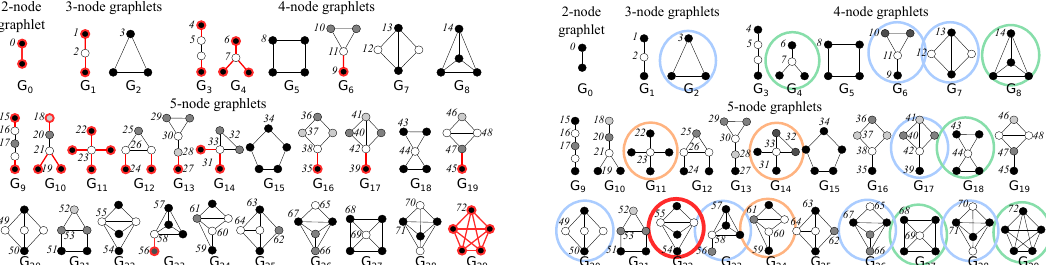
Figure 3: Left panel — Orbits coloured red are the most frequent ones in the newly added proteins (i.e., in the 2,525 proteins that exist in HI-2013, but not in HI-2011). Right panel — Presence of specific topological wirings (i.e., graphlets) in the full HI-2013 network. Circled graphlets are those for which a large portion of their counts in HI-2013 come from proteins added to